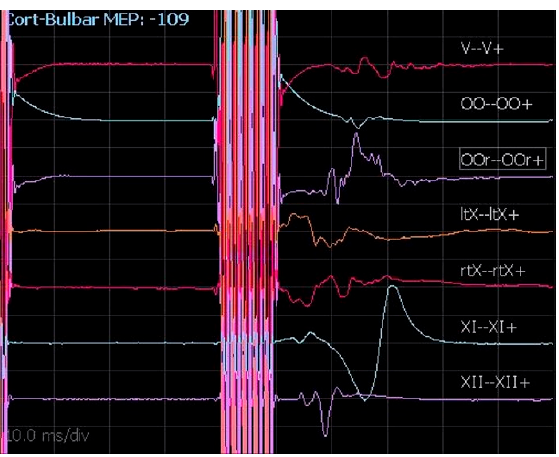
Figure 7. cMEPs registered from V, VII, X (left and right), XI, and XII cranial nerves.